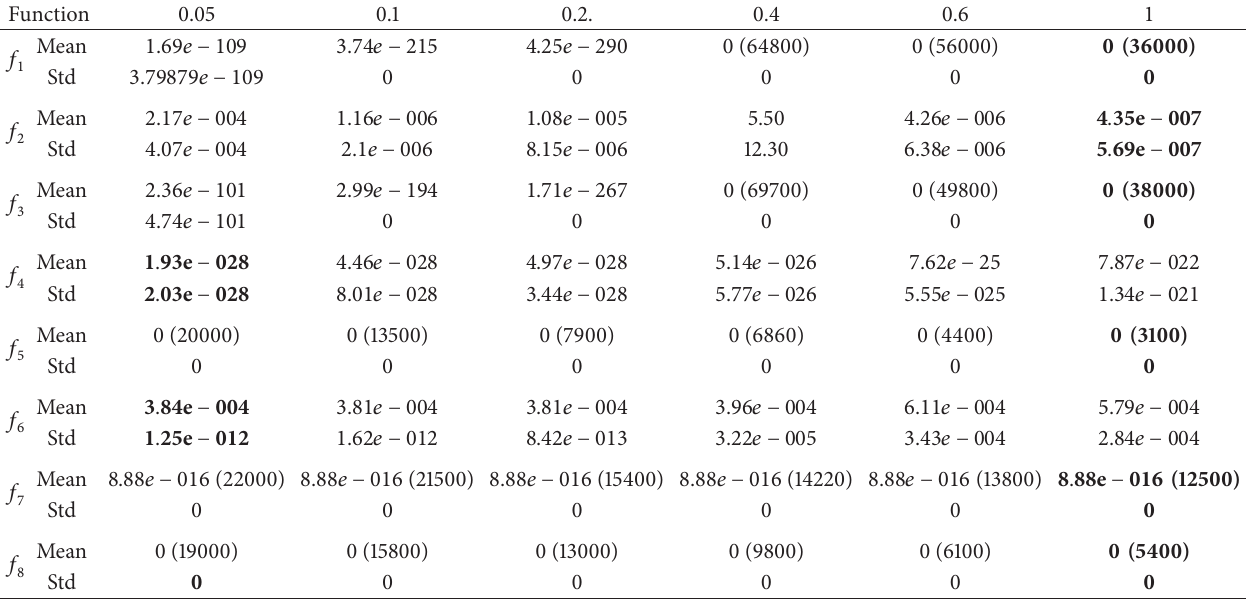
Table 4: Results of HABC AW on benchmark functions 𝑓 1 – 𝑓 8 with different CR. In bold are the best results.